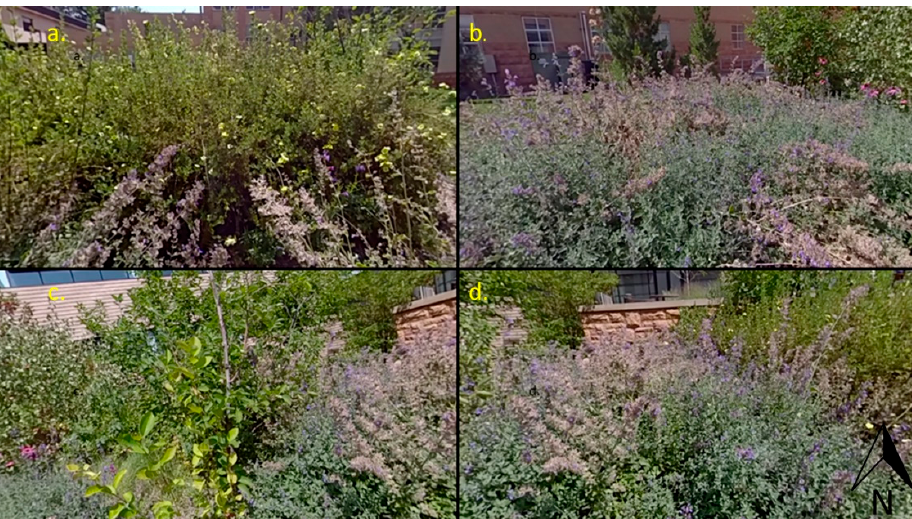
Figure 4. Actual view from each angle. View 1 ( a ) was dominated by Potentilla fruticosa ‘Katherine Dykes’. View 2 ( b ) was dominated by Perovskia atriplicifolia ‘Little Spire’. View 3 ( c ) was mixed between Amelanchier grandiflora ‘Katherine Dykes’ and Perovskia atriplicifolia ‘Little Spire’. View 4 ( d ) was mixed between Perovskia atriplicifolia ‘Little Spire’ and Potentilla fruticosa ‘Katherine Dykes.’.